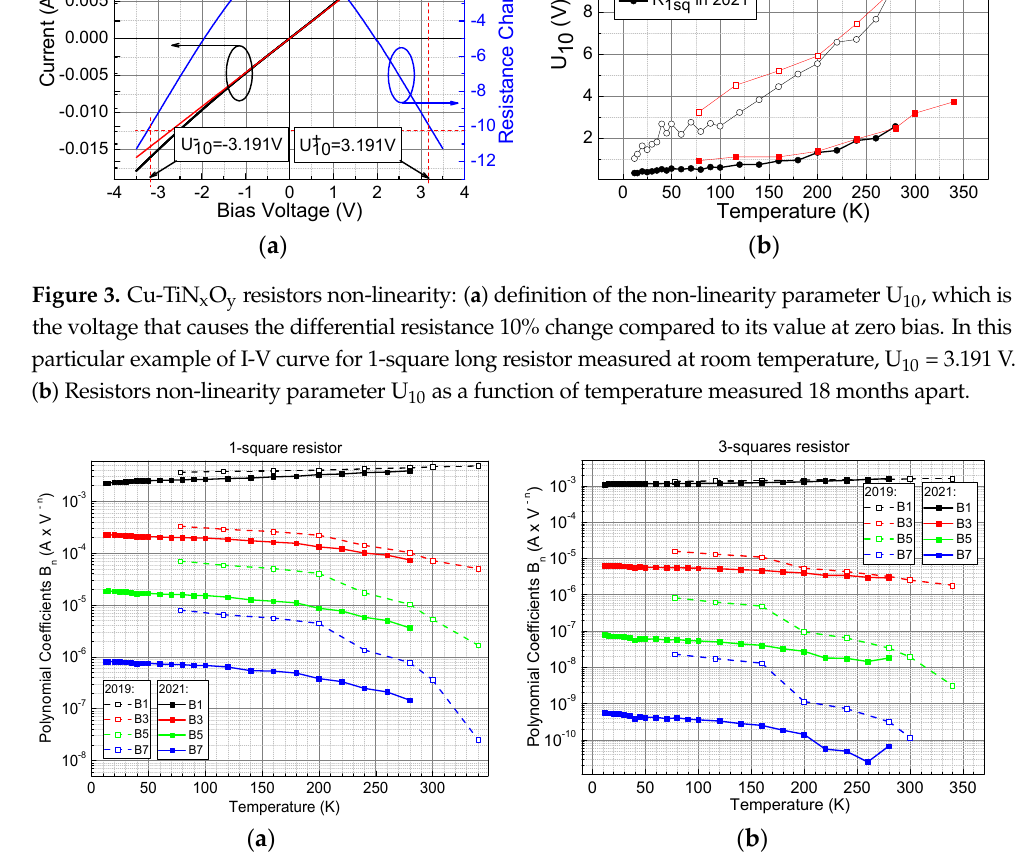
Figure 4. T-dependence of the coefficients absolute values for non-linear polynomial fit of experimental I–V curves for the following: ( a ) 1-square and ( b ) 3-square resistors. All coefficients were positive except for B 5 , which was negative.